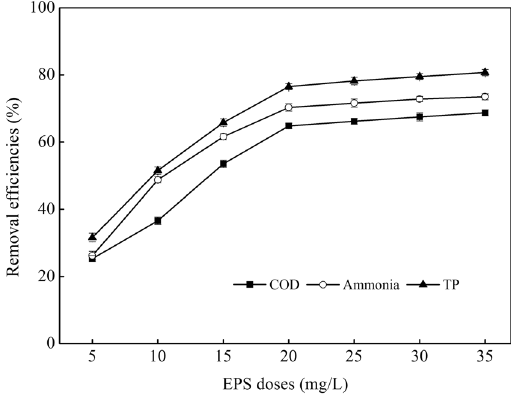
Figure 1. Effects of EPS doses on ADSW